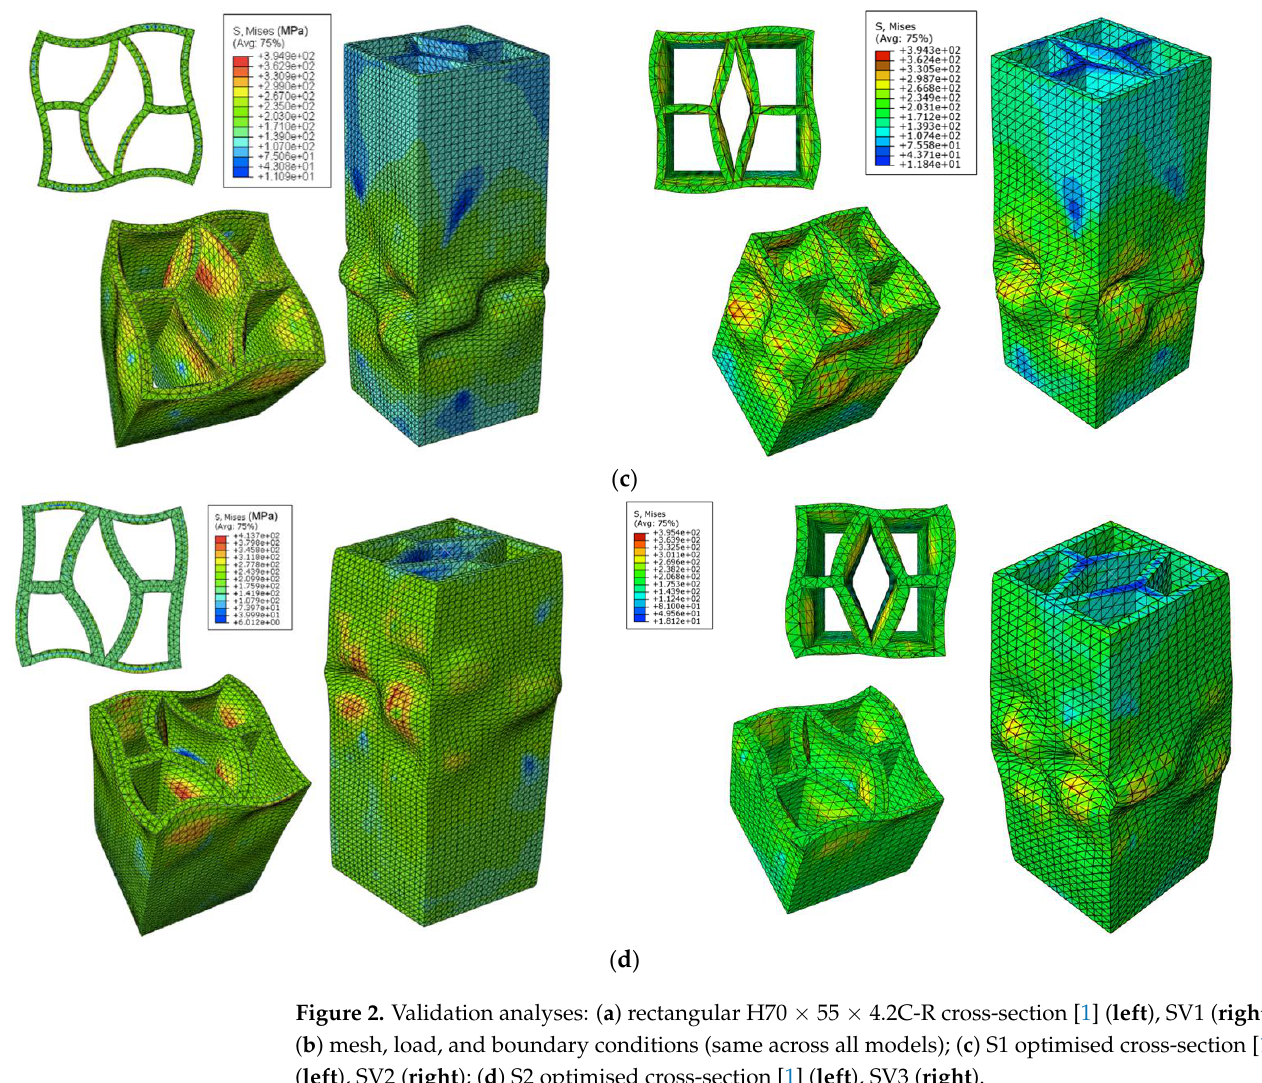
Figure 2. Validation analyses: ( a ) rectangular H70 × 55 × 4.2C-R cross-section [1] ( left ), SV1 ( right ); ( b ) mesh, load, and boundary conditions (same across all models); ( c ) S1 optimised cross-section [1] ( left ), SV2 ( right ); ( d ) S2 optimised cross-section [1] ( left ), SV3 ( right ).